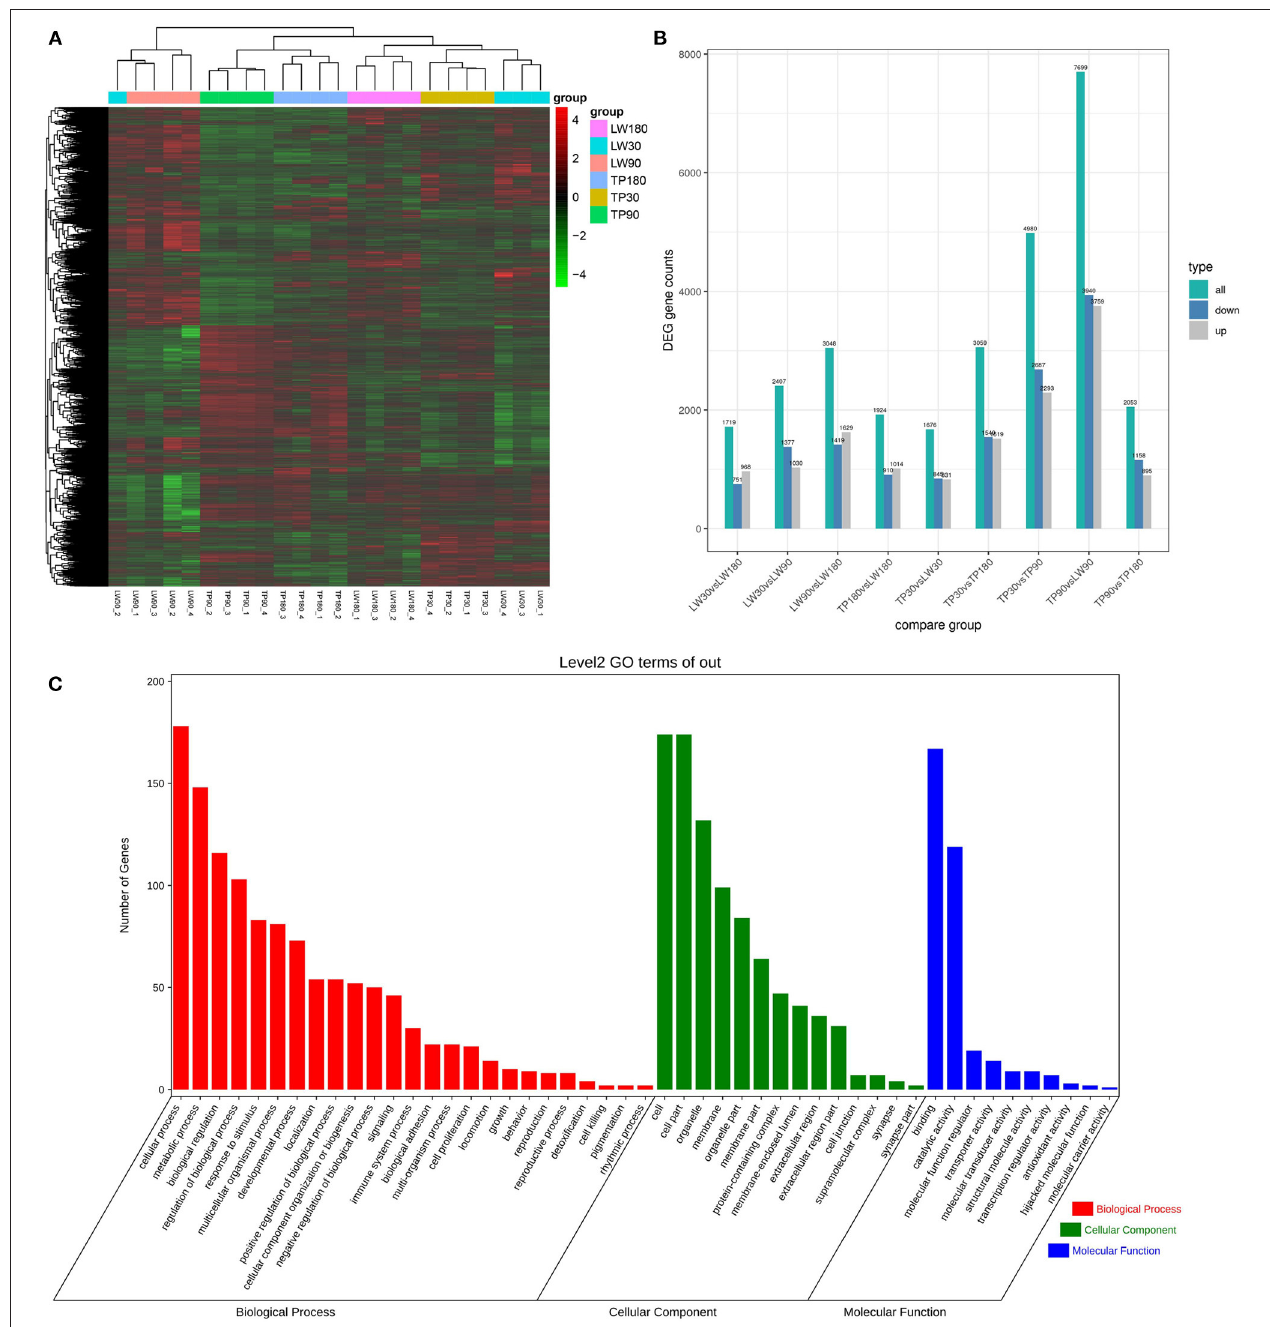
FIGURE 1 | Analysis of differentially expressed genes (DEGs). (A) Plot of correlation coefficient among samples. (B) Histogram of the number of DEGS statistics for difference comparison combinations. (C) The column diagrams for gene ontology (GO) analysis of DEGs, the X-axis represents the functions of GO analysis and the Y-axis represents the numbers of